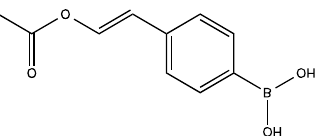
Figure 17. 4-(trans-3-methoxy-3-oxo-1-propen-1-yl)benzene boronic acid monomer.